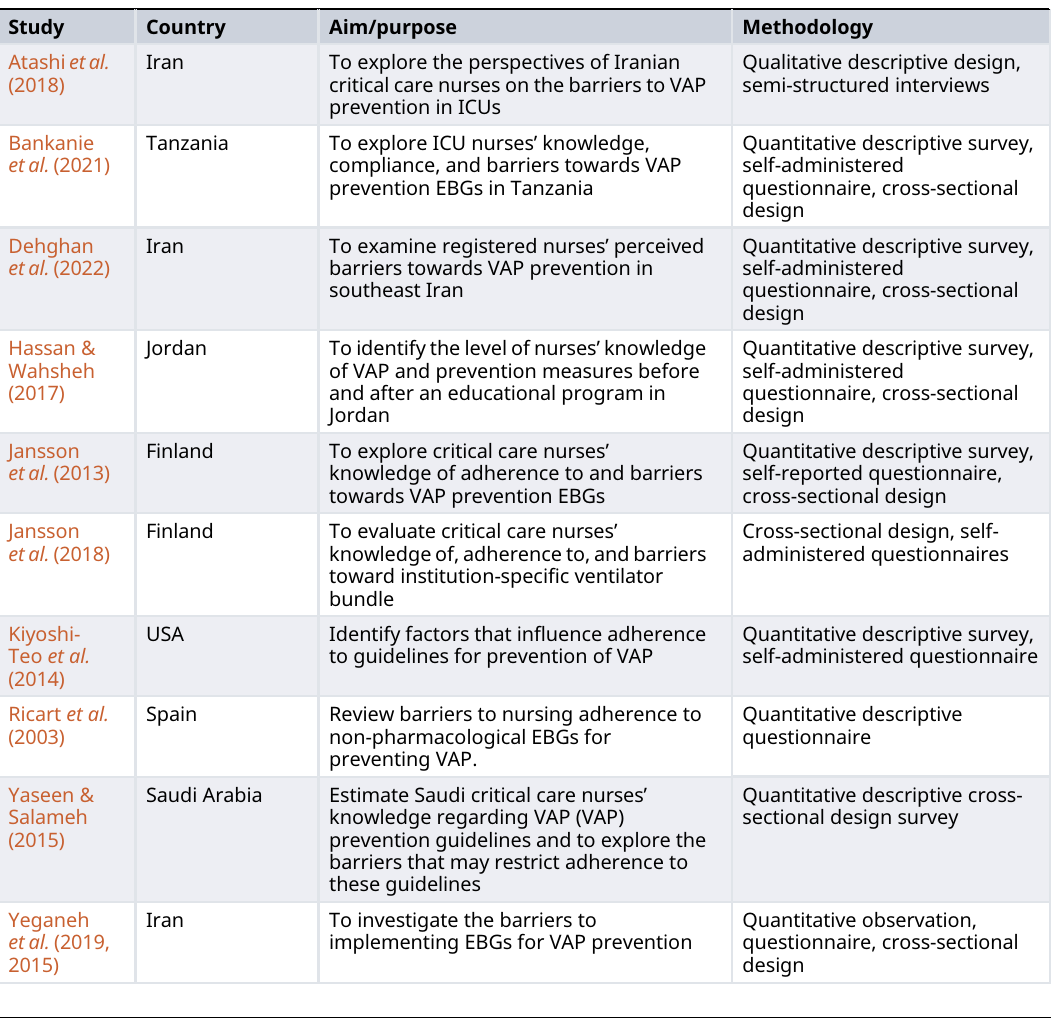
Table 4. Summary of key barriers identified (categories and subcategories).